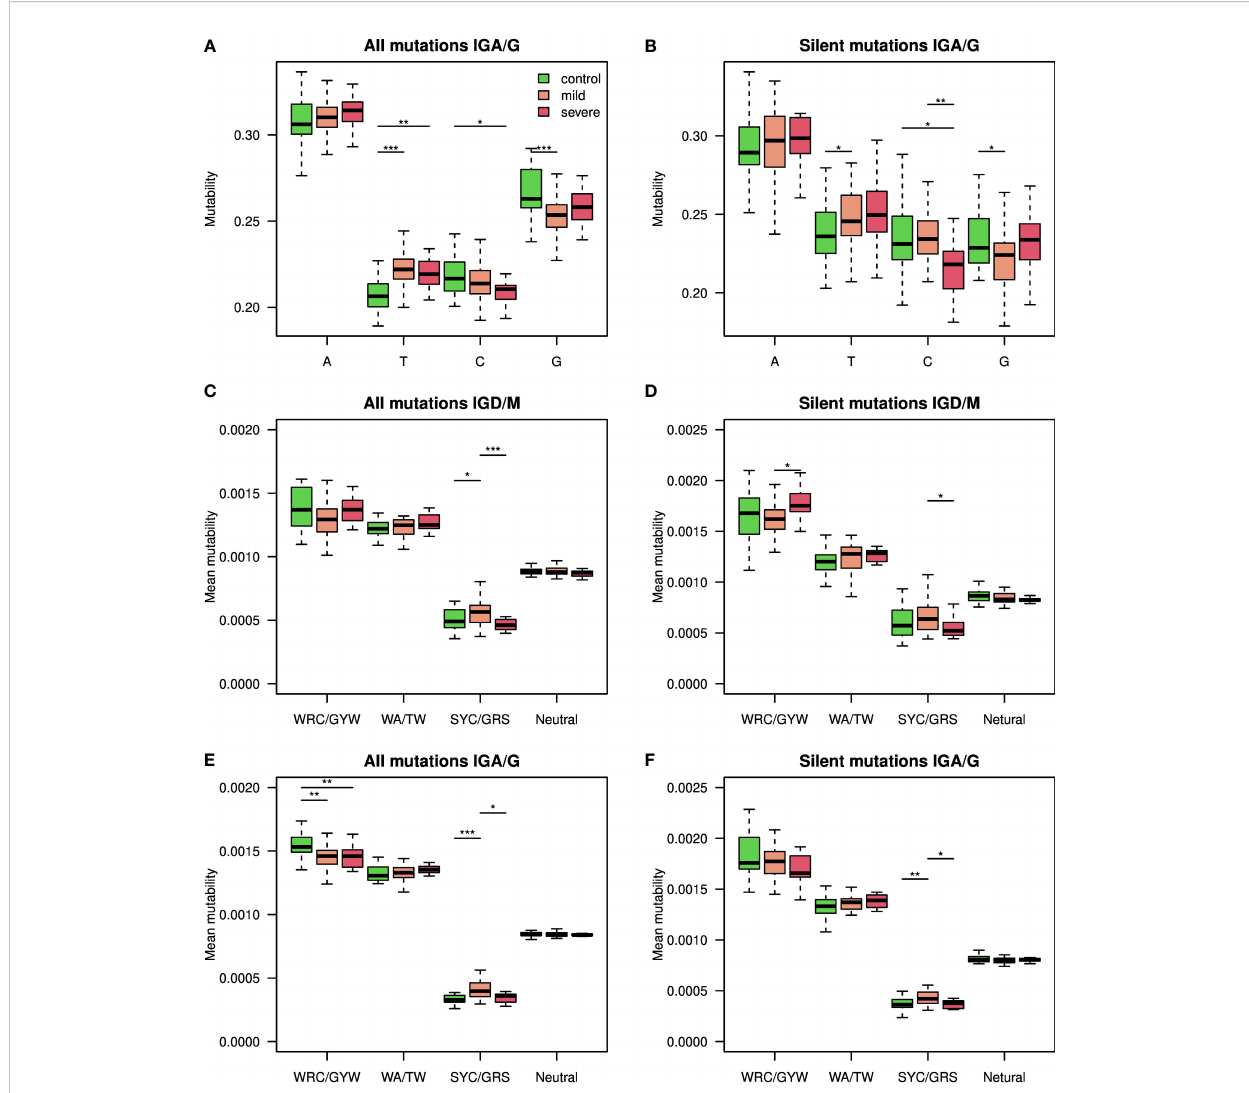
FIGURE 3 Silent and replacement mutability in SHM single base mutability, 5-mers hot-spots and cold-spots. (A) A single base mutability model was built based on IGA/G isotypes of COVID-19 patients and controls. Shown are boxplots representing the normalized sum of single base mutability. (B) The same plot as in A but for silent mutations only. (C, D) An 5-mer SHM model based on both silent and replacement mutations in (C) , or silent only mutations in (D) , was built using the IGD and IGM isotypes of COVID-19 patients at different severity levels and controls. Shown mutability of